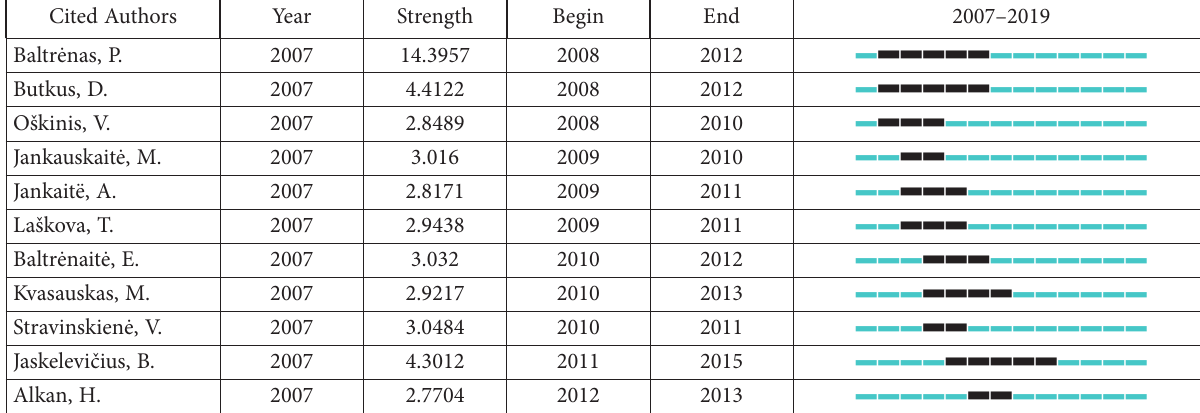
Table 7. Top 11 cited authors with the strongest citation bursts